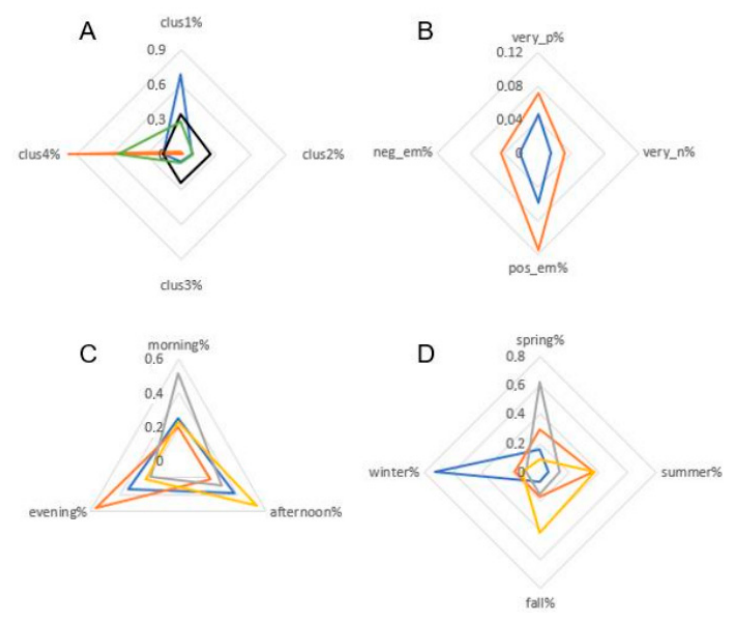
Figure 18. Sub-clusters for parks ( A ) user clusters; ( B ) sentiment and emotion proportions; ( C ) daily pattern; ( D ) seasonal pattern).